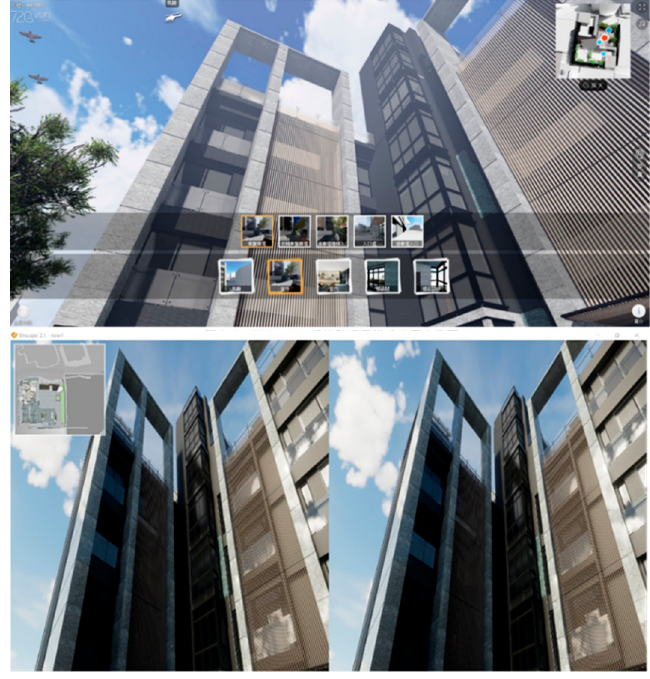
Figure 2. Virtual reality (VR) scene rendering and navigational walks.